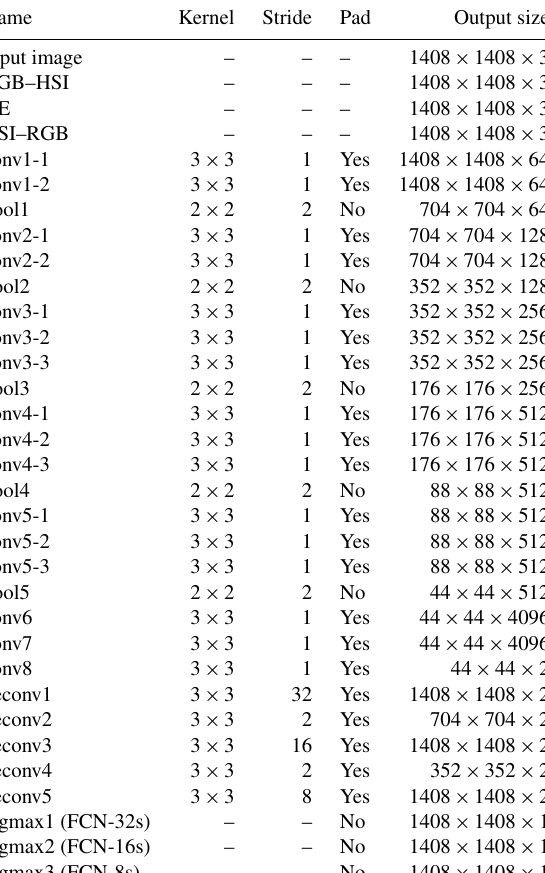
Table 1. Detailed parameters of the proposed EFCN-8s for seg- menting cloud pixels from ASI